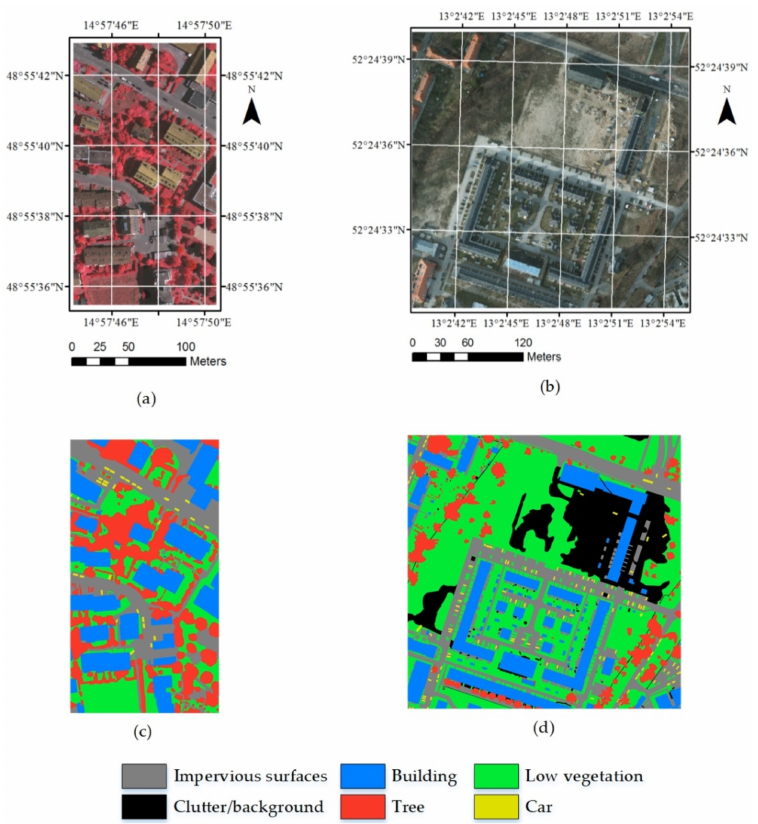
Figure 4. Two study images and their corresponding ground truth. ( a ) study image 1; ( b ) study image 2; ( c ) ground truth of study image 1; ( d ) ground truth of study image